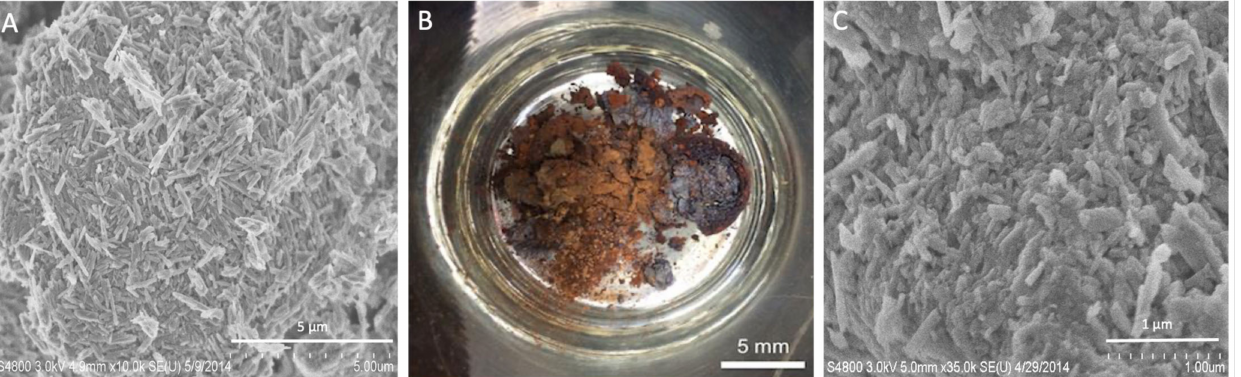
Figure 3. Iron-sintered halloysite. ( A ) Scanning electron micrograph (SEM) of native halloysite. ( B ). Iron-coated halloysite post-sintering. ( C ) SEM of sintered iron-coated